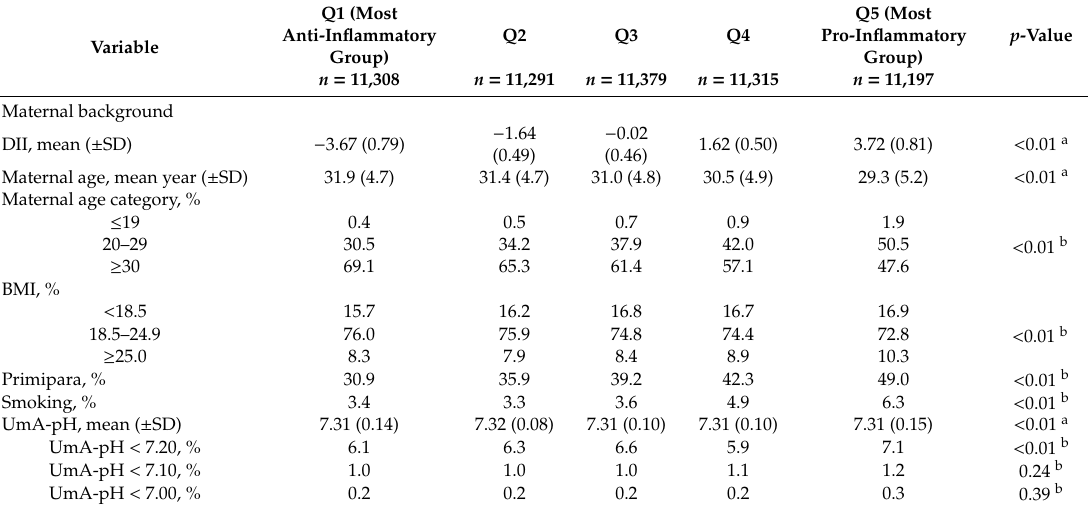
Table 1. Maternal medical background and obstetric outcomes.